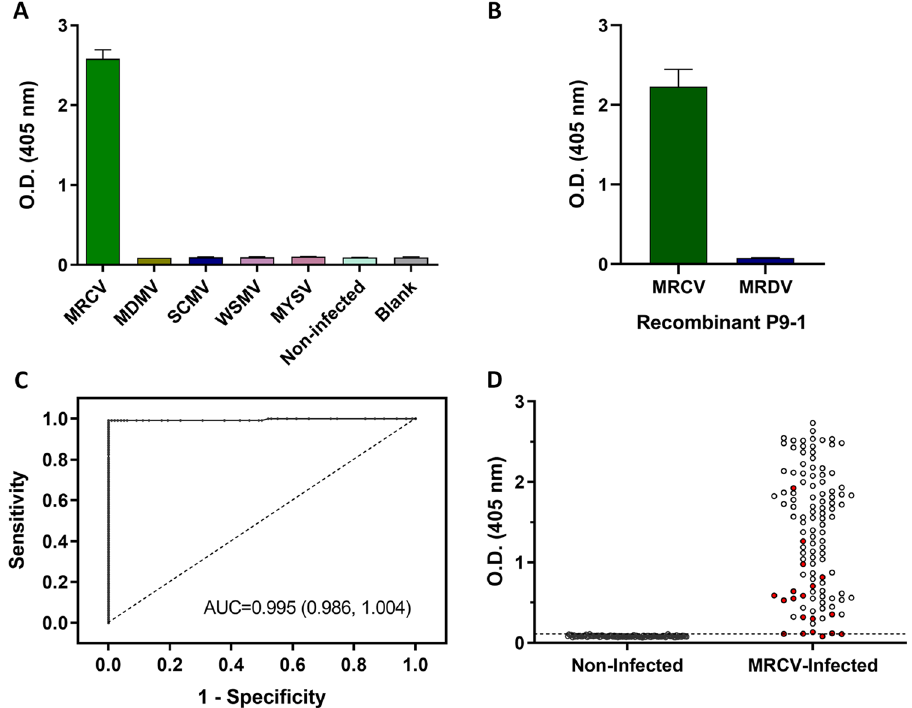
Figure 3. Specificity and sensitivity assessment of Nb-based sandwich ELISA. ( A ) For the analysis of the specificity, four different maize-infecting viruses were evaluated, MRCV was used as a positive control. Maize dwarf mosaic virus (MDMV, Potyvirus , Potyviridae ), Sugarcane mosaic virus (SCMV, Potyvirus , Potyviridae ), Wheat streaked mosaic virus (WSMV, Tritimovirus , Potyviridae ), Maize yellow striate virus (MYSV, Cytorhabdovirus , Rhabdoviridae ); ( B ) Sandwich ELISA on recombinant MRCV P9-1 and MRDV P9-1. Values are means ± SD (n = 3) ( C ) Receiver-Operating Characteristic (ROC) analysis from a total of 98 non-infected and 114 MRCV-infected samples. ( D ) Dot diagram for the 212 samples evaluated. Dashed line represents the cut-off obtained from the ROC curve analysis. Red dots indicate the infected plants classified as asymptomatic whereas white dots indicate those classified as